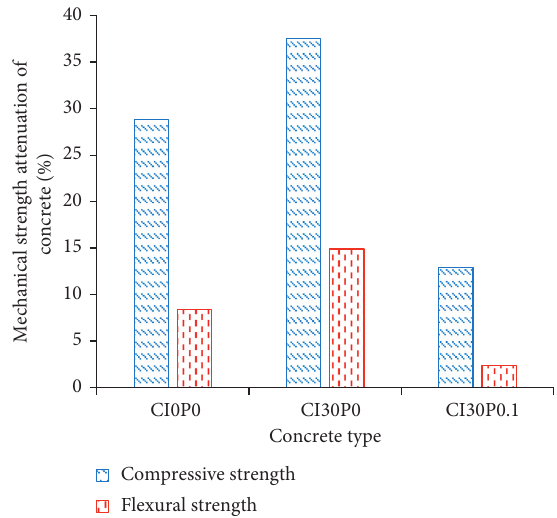
Figure 13: Attenuation of the compressive strength and flexural strength of the